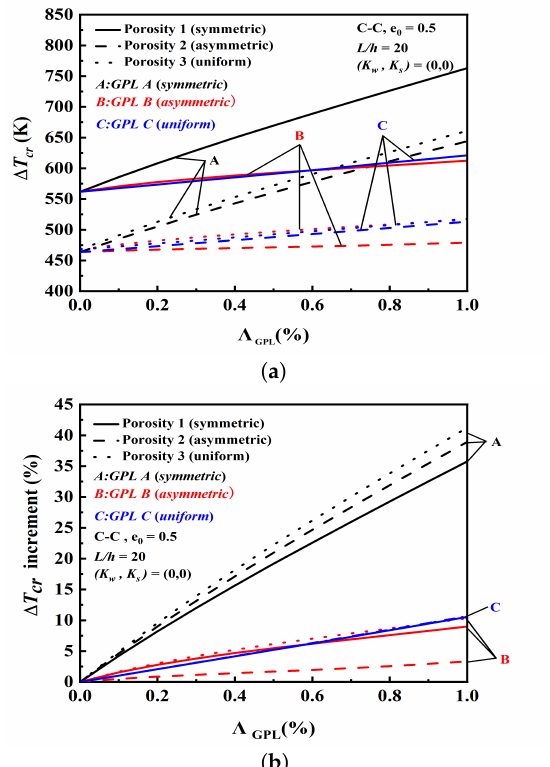
Figure 6. Effect of GPL weight fraction Λ GPL on critical buckling temperature rise and its percentage. ( a ) Effect of GPL weight fraction Λ GPL on critical buckling temperature rise. ( b ) Effect of GPL weight fraction Λ GPL on the percentage of critical buckling temperature